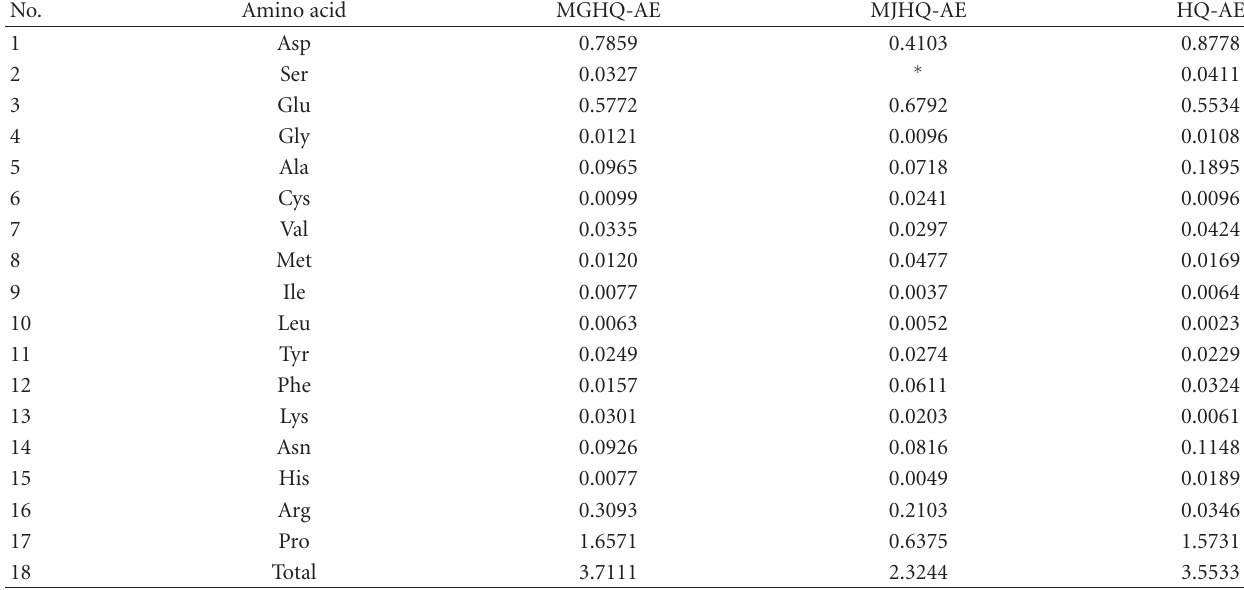
Table 4: Amino acid contents of MGHQ, MJHQ, and HQ (g/kg).